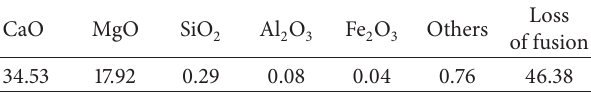
Table 1: Chemical composition of dolomite